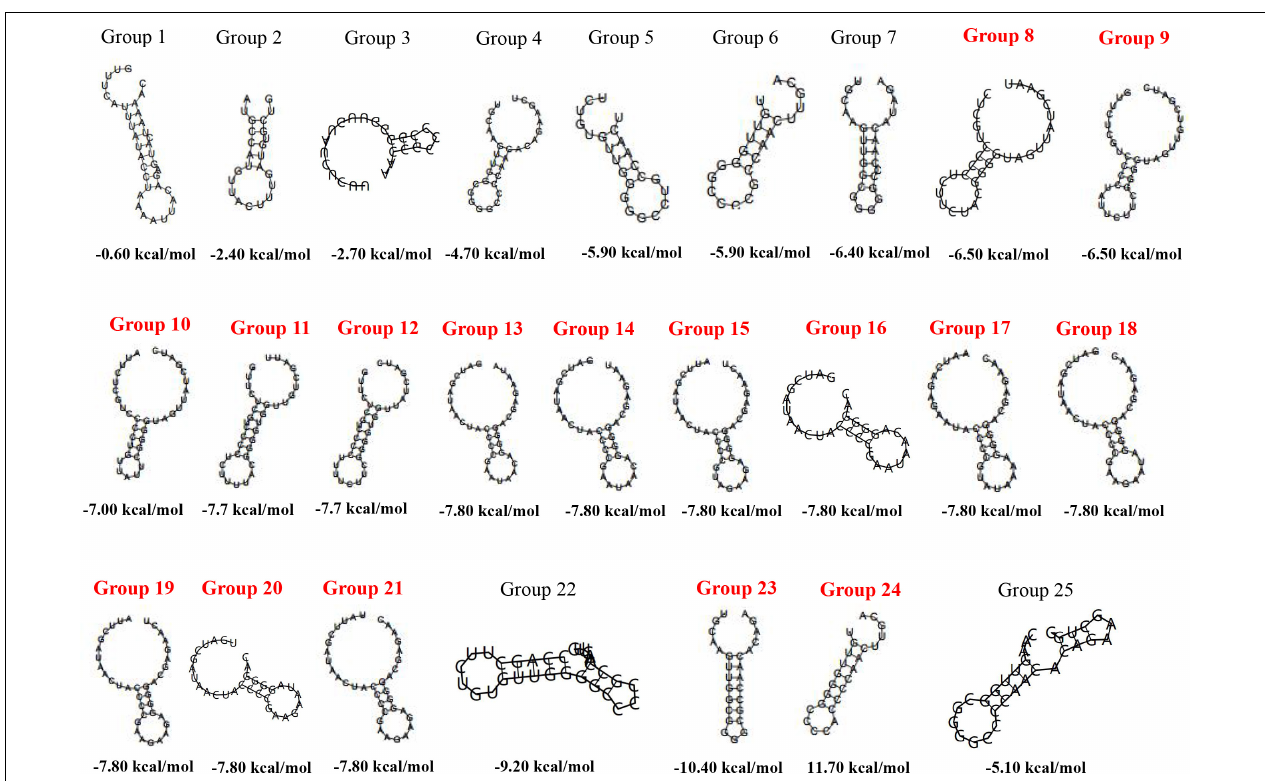
FIGURE 2 | The RNA secondary structures and the MFE of the 25 group of CDRs. The CDRs from the CRISPR-Cas system are marked in